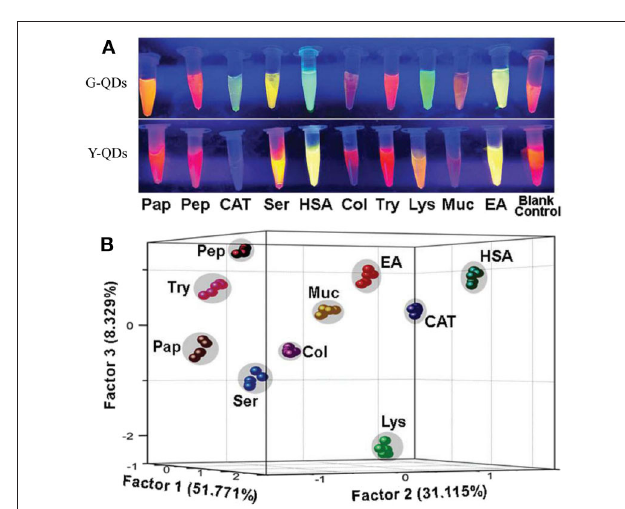
FIGURE 9 | (A) FL variation images of G-QDs and Y-QDs with and without proteins under the UV-light irradiation. (B) PCA canonical score plot for identifying corresponding proteins. Reprinted from Ma et al. (2017) with